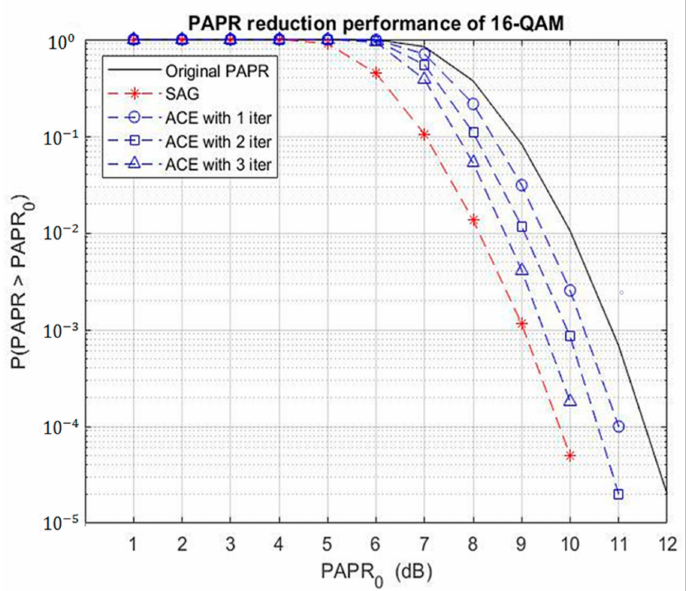
Figure 7. PAPR reduction performance comparisons of the 16QAM–OFDM with the SAG and ACE method with one to three